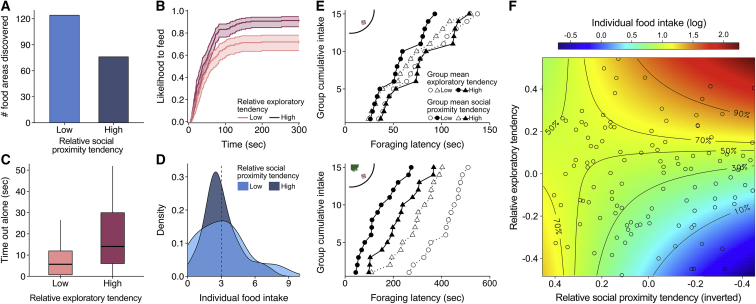
Effects of Individual Social Proximity and Exploratory Tendencies on Group Foraging Dynamics(A) Total number of foraging areas discovered during the open foraging context trials (out of 295 discoveries).(B) Inverted survival plot with confidence intervals of fish's likelihood to feed in the open and semi-covered foraging context.(C) Boxplots depicting total time spent out of plant cover alone in the semi-covered foraging context when food was still available.(D) Density plot of the mean number of food items eaten per trial across both foraging contexts.For plots (A)–(D), individual tendencies were evenly distributed into low, medium, and high categories (n = 42, n = 42, and n = 41 fish, respectively), with the intermediate category not shown for clarity.(E) Group foraging speed in the open (top) and semi-covered foraging cover context (bottom) in terms of the latency to consume each food item (15 provided per trial). The plot shows latencies averaged across trials for each group, and groups split into four categories based on their mean exploration and social proximity tendencies (low-low, low-high, high-low, and high-high: n = 5, 8, 8, and 4, respectively).(F) Surface plot of the mean number of food items eaten (log transformed) in the open foraging context (points indicate individual fish), based on a generalized linear mixed model (GLMM) fit to the data, cropped to 90% to show the effect excluding fish with the most extreme tendencies (n = 12 fish). Relative social proximity tendency is shown inverted such that faster fish are on the right and slower fish on the left, directly comparable with the model simulations of speed (see Figure S4).